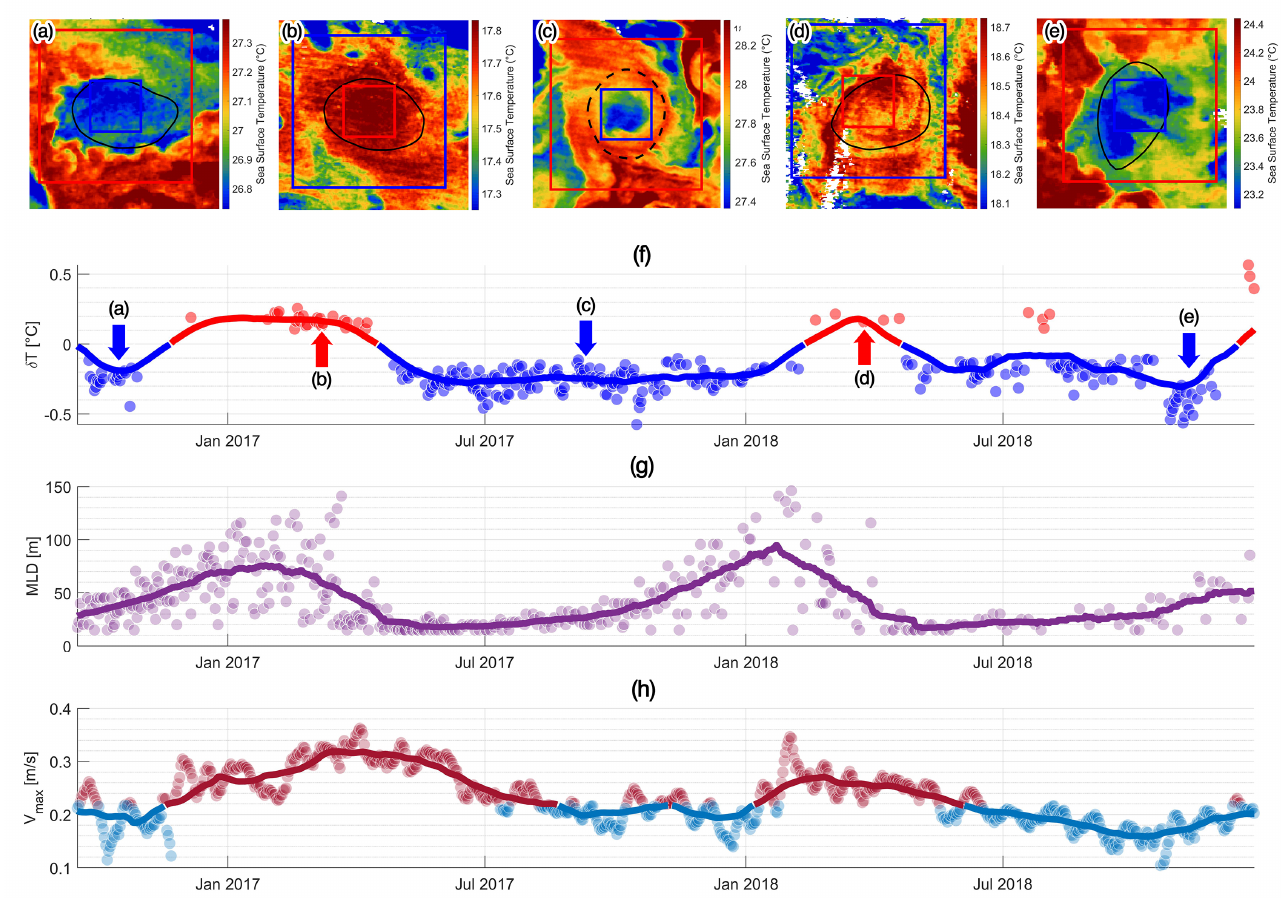
Figure A2. Timeline of the Cyprus (Eratosthenes) anticyclone with DYNED ID #10754. Panels ( a – e ) show four characteristic SST patches corresponding with the δ T evolution in panel ( f ). Panel ( g ) shows the evolution of the MLD outside the eddy. Panel ( h ) shows the evolution of the maximal velocity. Lines represent the Monthly Mean Average of each variable. For more information, the reader is referred to Figure